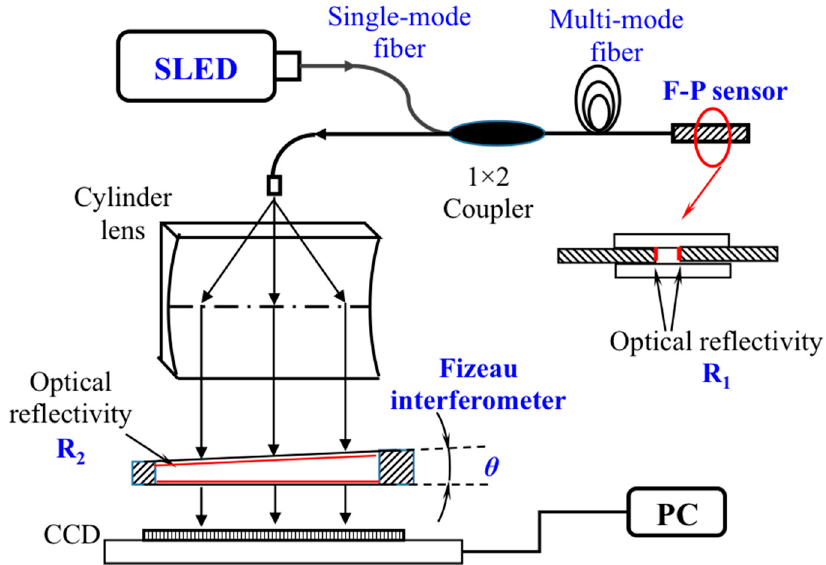
Figure 2. A schematic of the optical Fabry-Perot (F-P) non-scanning correlation demodulation system. (SLED, super luminescent light emitting diode; CCD, charge coupled devices; PC, personal